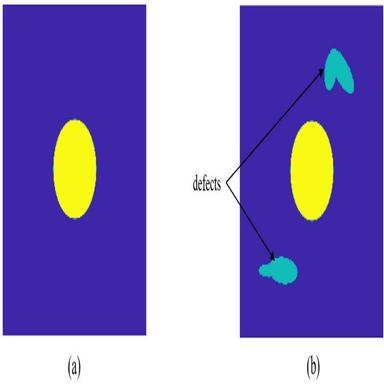
Model for defect discovery. (a) Original model as the input for the RVE-net (b) Actual model with two defects.